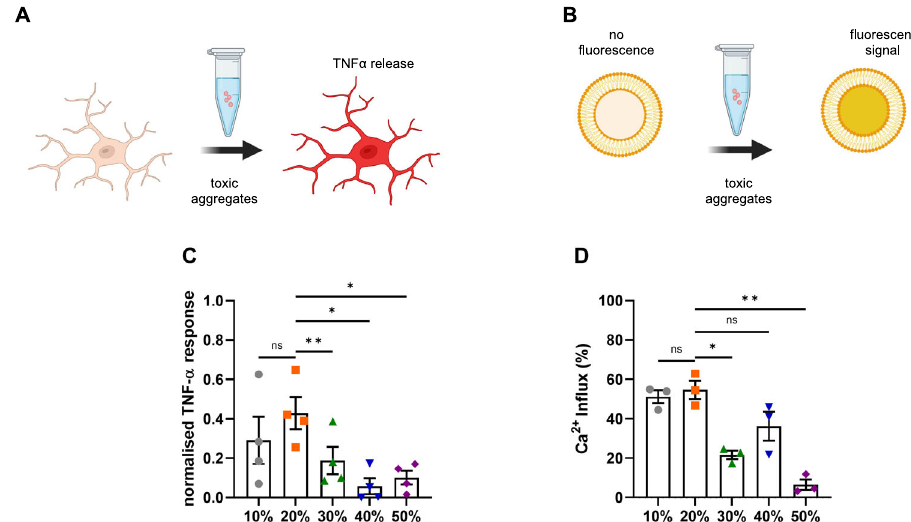
Fig. 6 | Size is linked to toxicity. A Upon addition of toxic aggregates, BV2 microglial cells release TNF- α into the culture medium, which is measured in the supernatant. B Liposomesare fi lledwithaCa 2+ -sensitivedye.Uponincubationwith toxic aggregates, Ca 2+ from the buffer can enter the liposome and cause a fl uor- escentsignal. C TNF- α responsefromBV2cellsupon24hincubationwithdifferent sucrose fractions. The data are normalized to the negative control (buffer) and positive control (LPS at 10ng/mL). Error bars are mean±SEM from four indepen- dent biological replicates. Matched one-way ANOVA with Geisser-Greenhouse correction and Dunnett ’ s multiple comparison test with a signi fi cance level of α =0.05. Corresponding p -values are 10% vs 20% p =0.288, 20% vs 30% p =0.006,